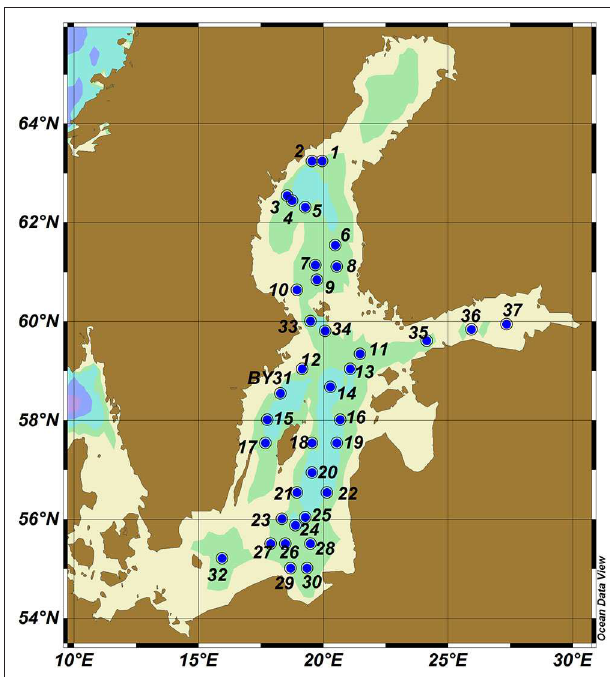
FIGURE 3 | Location scheme of points in the Baltic Sea selected for the